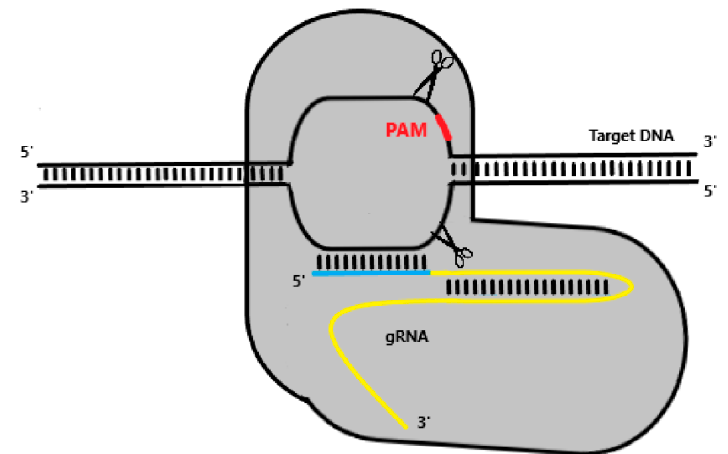
Figure 2. Representation of clustered regularly interspaced short palindromic repeats (CRISPR) Cas9-mediated gene editing. Upon recognising an adequate PAM site (red), the targeting sequence (blue) of gRNA (yellow) begins to anneal to the target DNA in the 3 ′ -5 ′ direction. If enough homology between strands exists, Cas9 undergoes a conformational change that ultimately results in a blunt DSB.